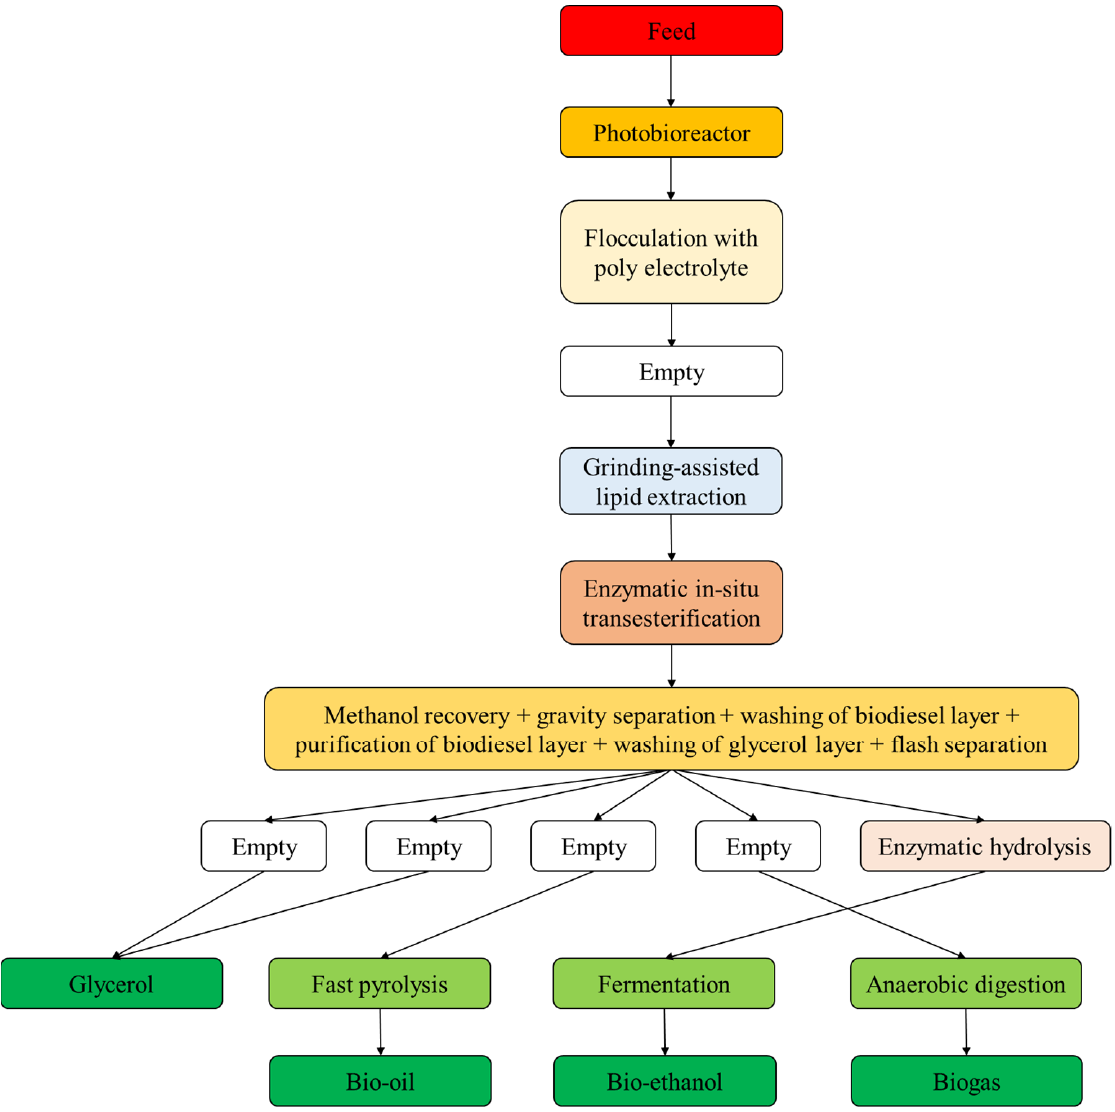
Figure 5. Optimal processing pathway in Scenario 1.